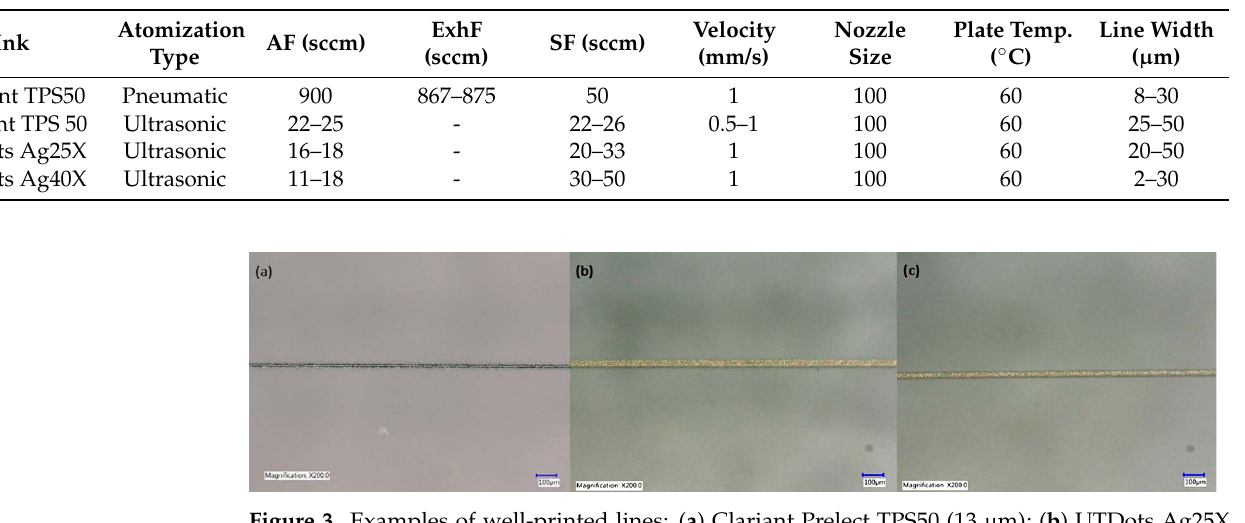
Table 3. Established printing parameters for inks used: AF, atomization flow; ExhF, exhaust flow; SF, sheath flow. Con- sidering PA physics, formula [ExhF–AF] gives the actual value of the atomization flow at the nozzle.